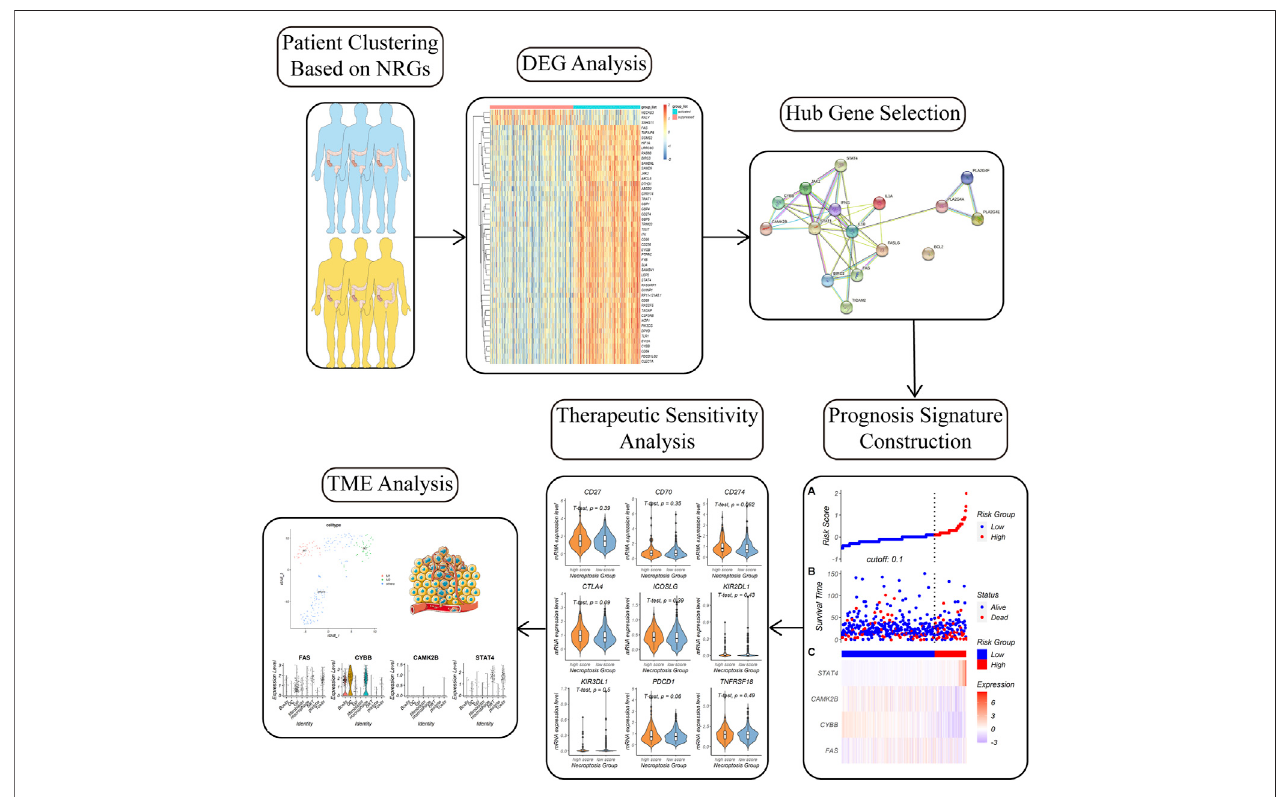
FIGURE 1 | Work fl ow of the study. Colon cancer patients were divided into two subgroups with distinct molecular and clinicopathologic features based on necroptosisrelatedgenes(NRGs).Differentialgeneanalysis,hubgeneanalysis,lassoregression,andmultivariateCoxregressionwascarriedstepbystepto fi gureouta necroptosis signature. The necroptosis signature could predict prognosis and therapeutic response in colon cancer patients. We also investigated the relationship between the necroptosis signature and tumor microenvironment (TME) by single-cell analysis.